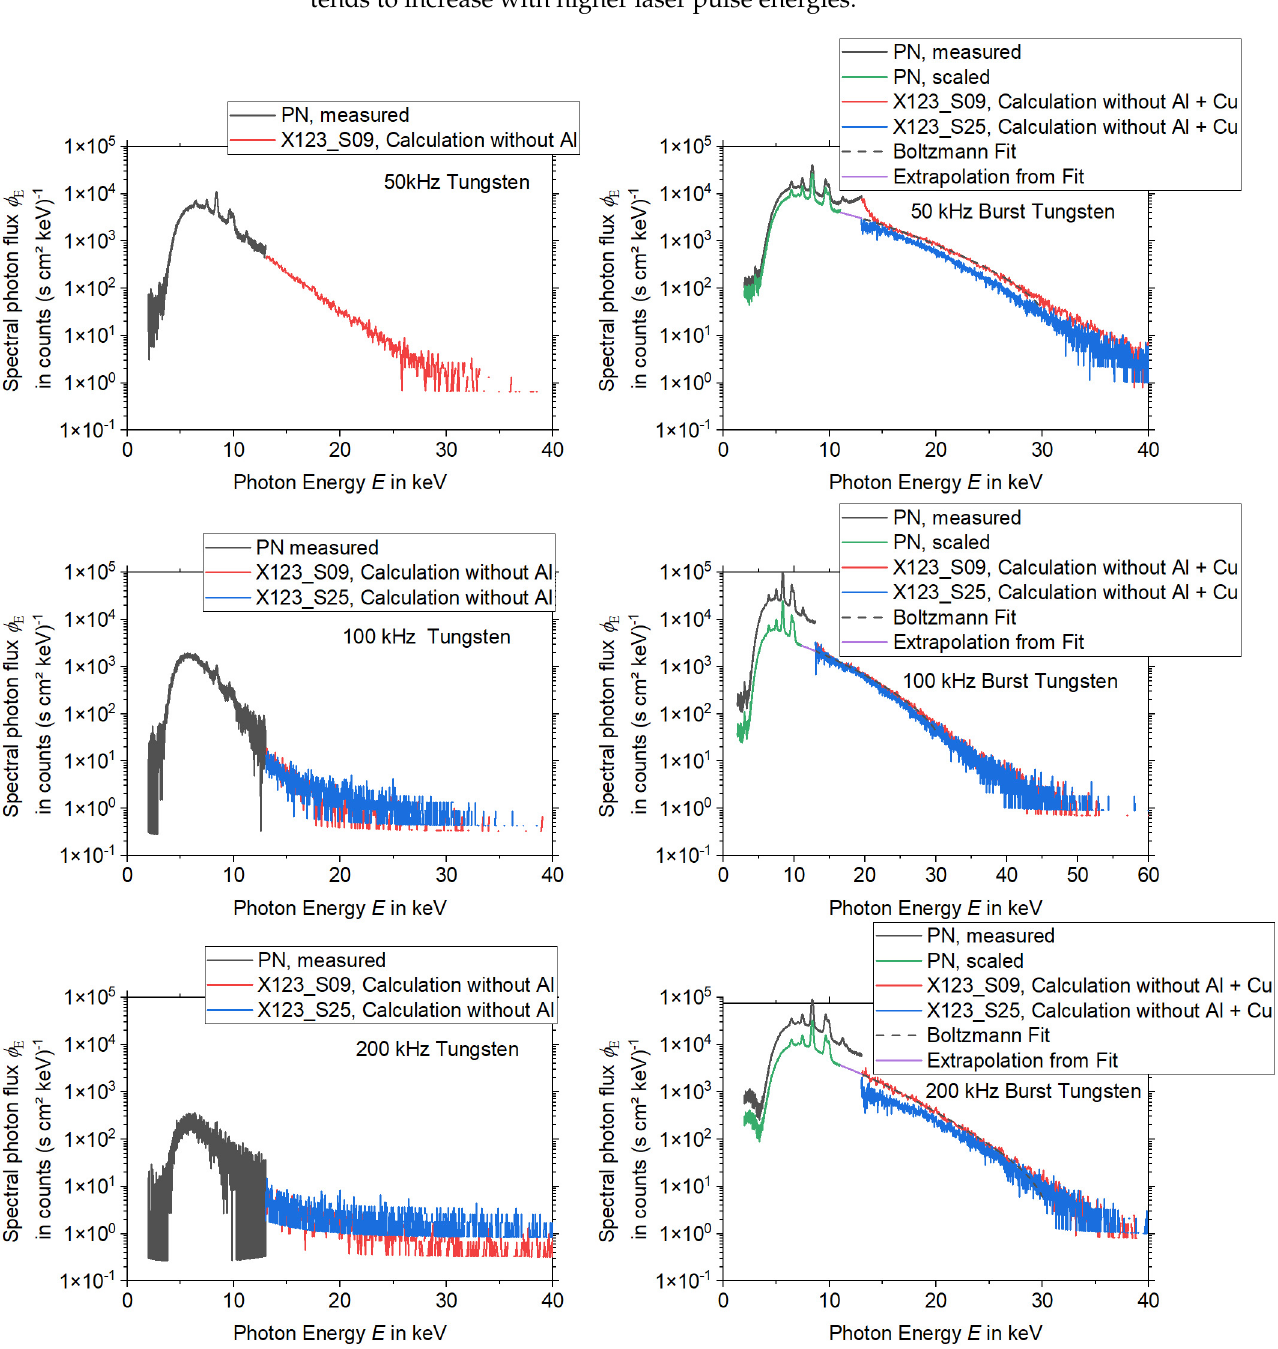
Figure 8. X-ray spectra during the processing of tungsten. Detector type, filter materials, and evaluation constraints are indicated through labels for the different curves. Note the logarithmic scaling of the ordinate axes.